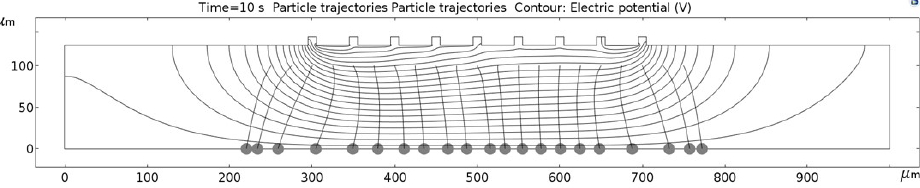
Figure 11. Computed particle trajectories and electric potential for the ideal electric potential BC.